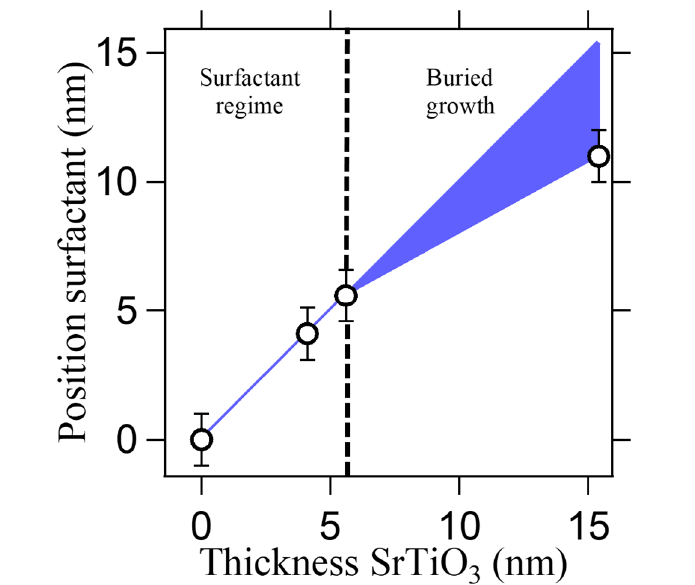
Fig.4. The surfactant position as a function of STO thickness. The suggested dielectric/ferroelectric growth model interface presents a surfactant regime (left) and a buried growth